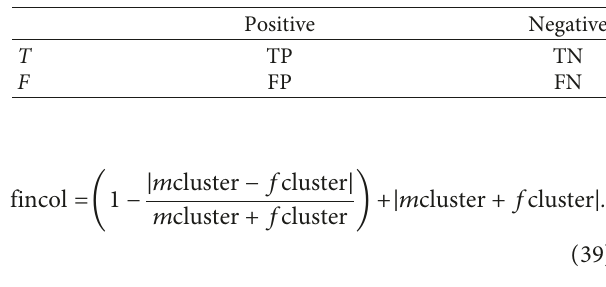
Figure 4: Schematic diagram of classification results. Table 1: Confusion